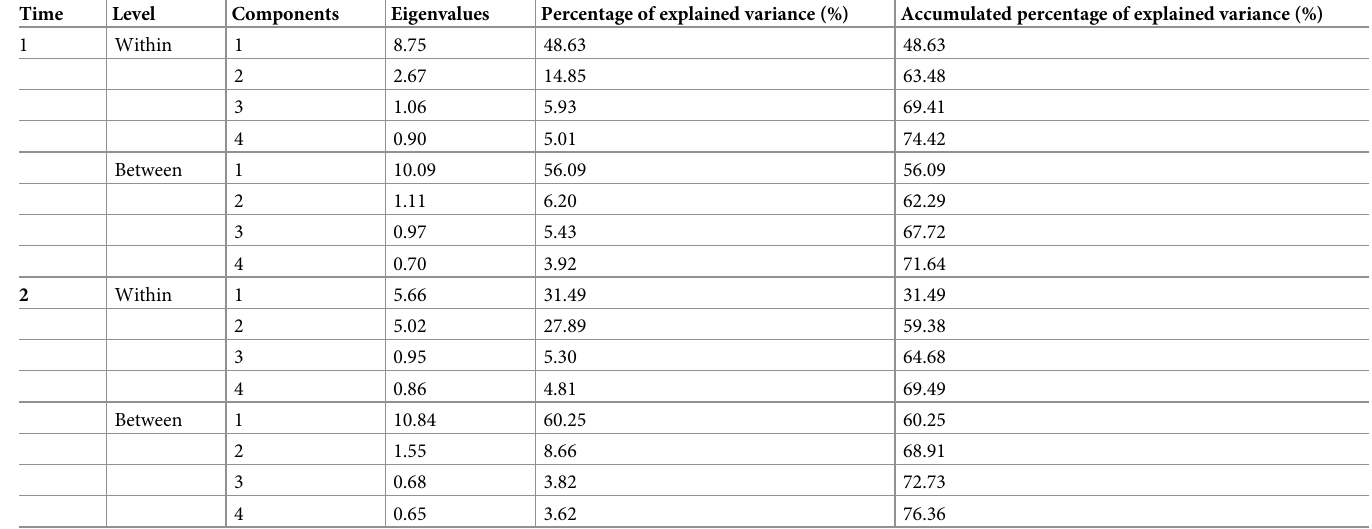
Table 6. Eigenvalues, percentage of explained variance (%) and accumulated percentage of explained variance for within and between sample correction matrix at for 18 items at Time 1 and Time 2. Time